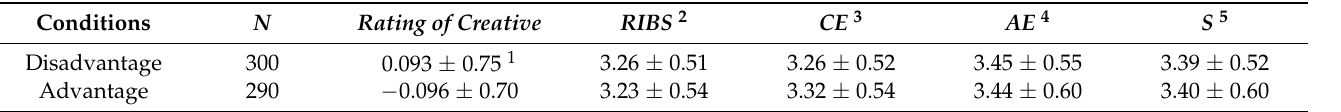
Table 1. Descriptive statistics for creative product evaluation by condition and the scores for the RIBS, cognitive empathy, affective empathy, and sympathy.